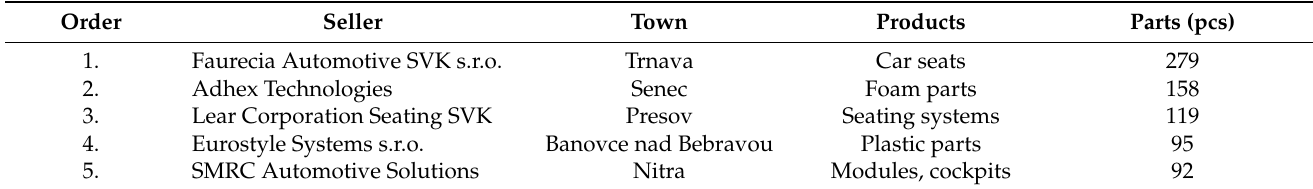
Table 2. The most important PSA Group SVK suppliers in 2019 in terms of the number of types of imported